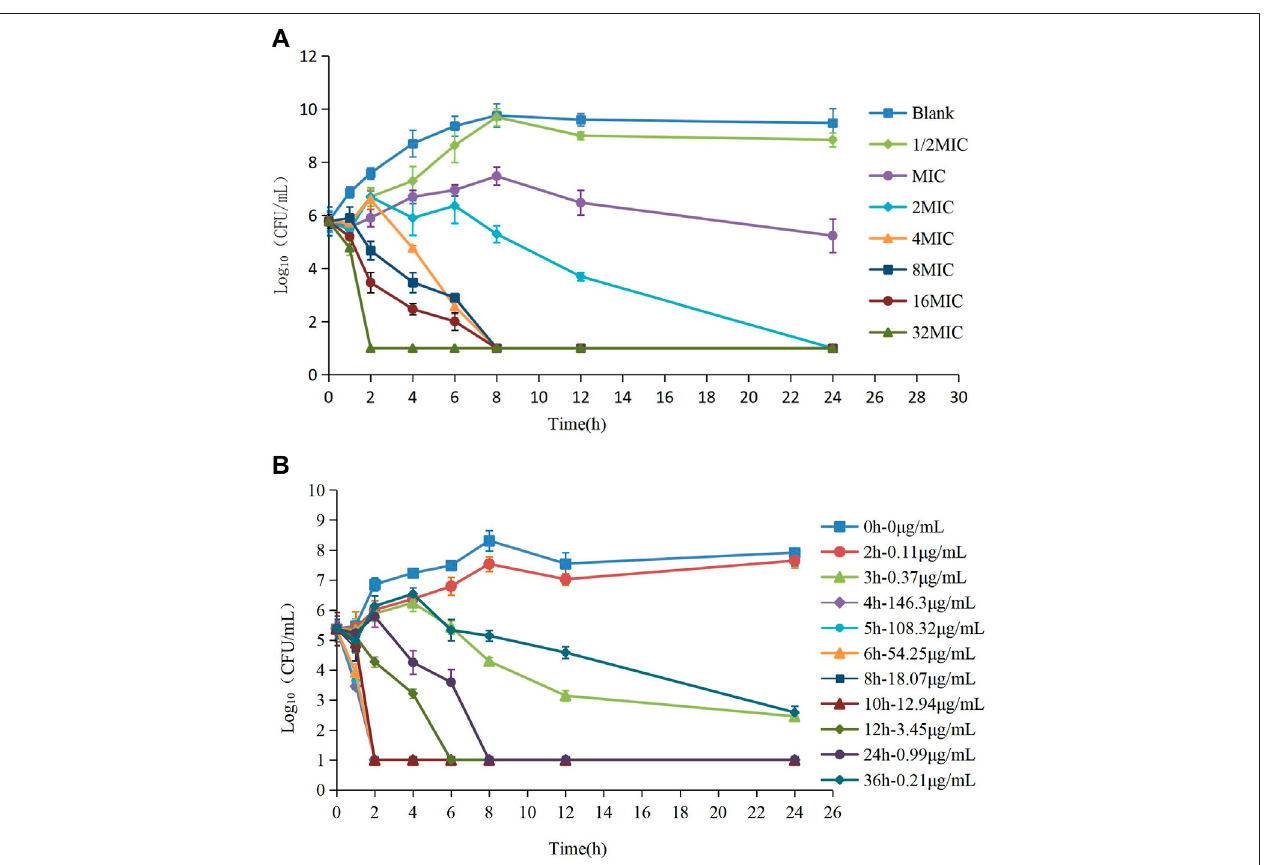
FIGURE 2 | (A,B) The killing curves of avilamycin against Clostridium perfringens in vitro and ex vivo .